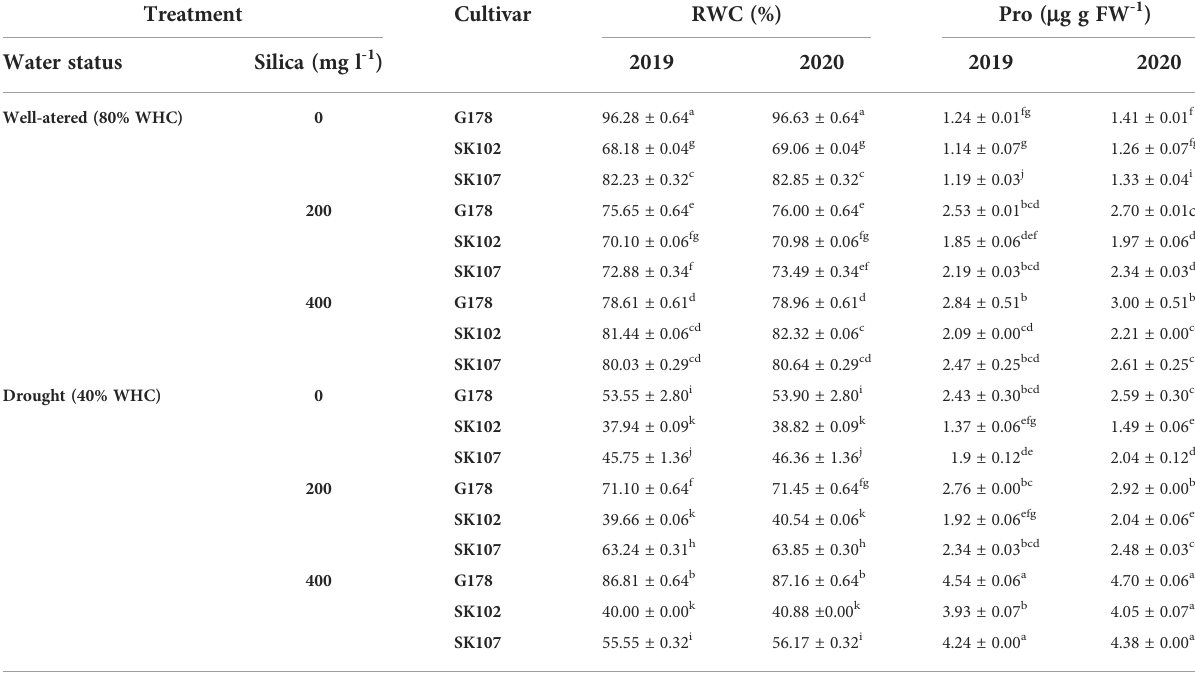
TABLE 4 Effects offoliar application of silica on RWC and proline content in response to drought stress during the growing seasons of 2019 and 2020.